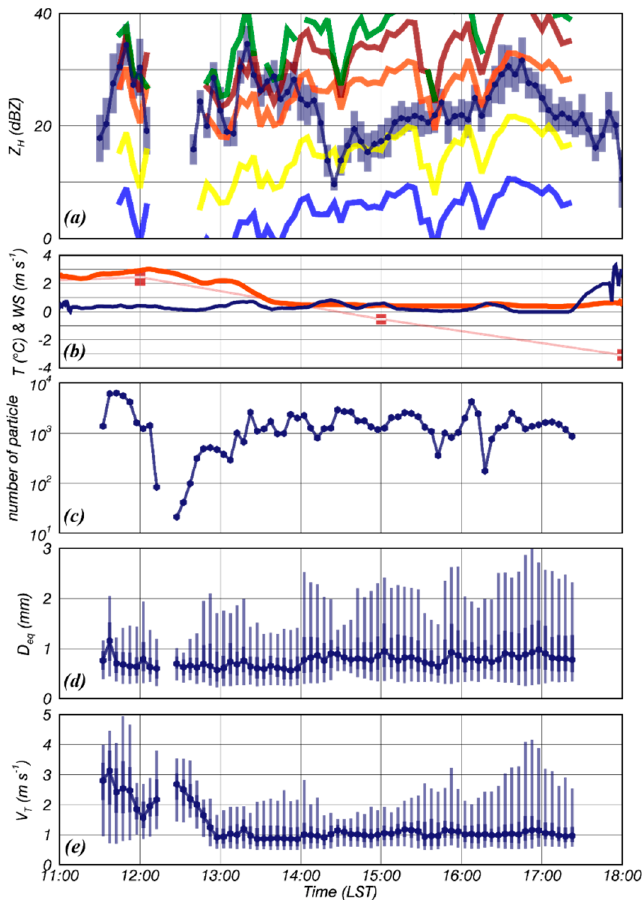
Figure 13. Time series of ( a ) Z, ( b ) T, WS, and T 6 , and physical variables in 5 min intervals observed using the 2DVD: ( c ) N 5 , ( d ) quartiles of D, and ( e ) quartiles of V T for C2 (28 February 2016). The thin solid dark blue line in Figure 13a indicates the 3 ray-5 gate averaged Z O and its standard deviation. The blue, yellow, orange, and brick colored solid lines correspond to Z S under T values of − 4 ◦ C, 0 ◦ C, 1 ◦ C, and 2 ◦ C, respectively. The green solid line in Figure 13a denotes Z S for the condition of a totally melted snowflake. The solid orange and blue lines in Figure 13b correspond to T and WS, respectively. The red solid line and vertical bar plot mean the average and standard deviation of T 6 ,